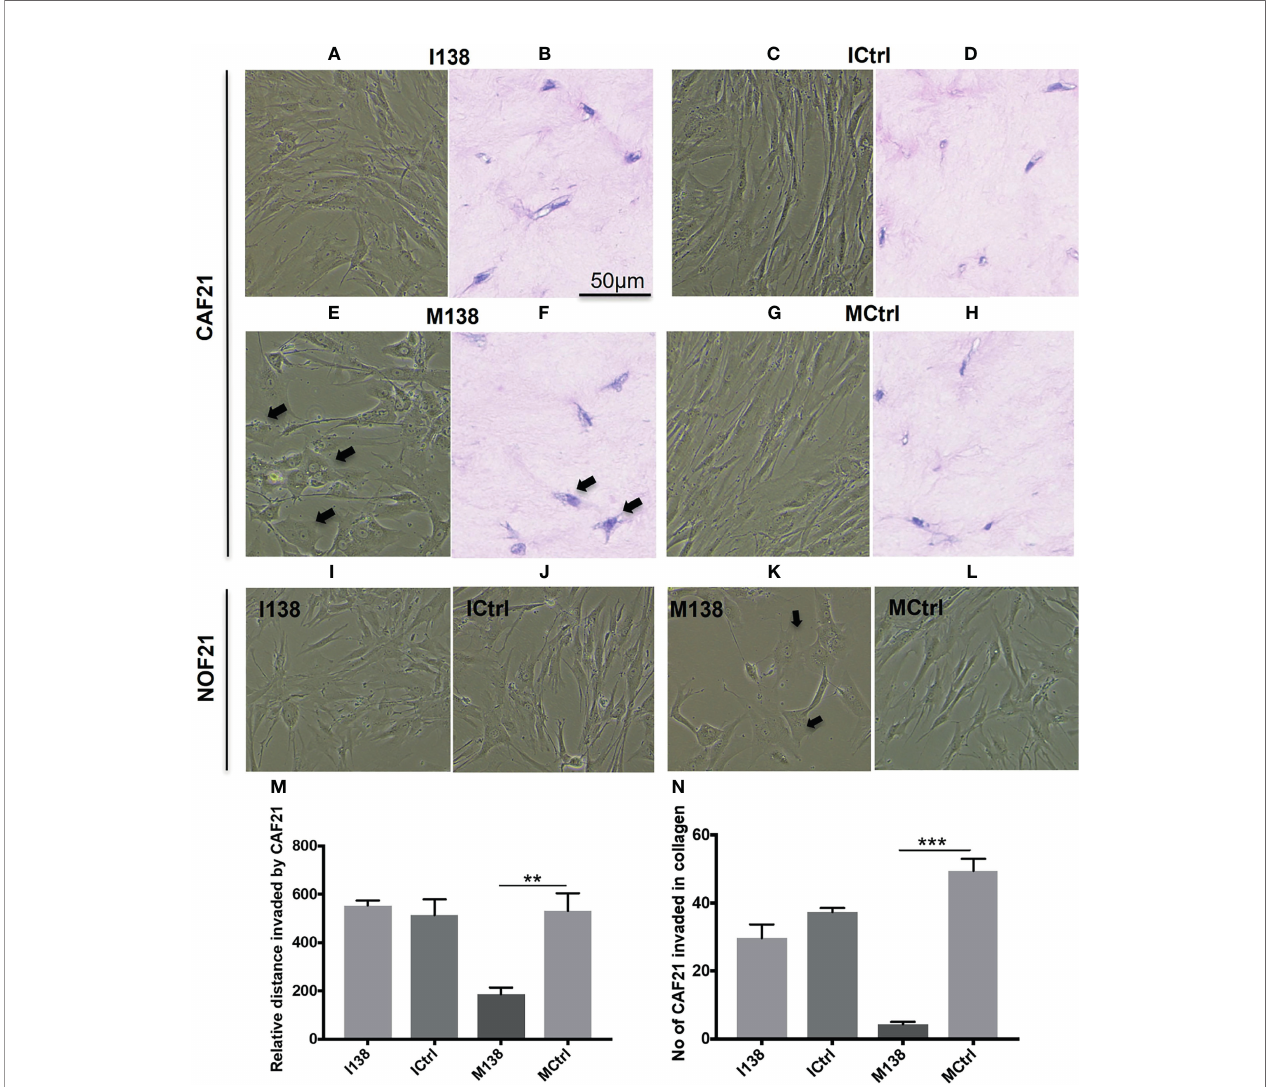
FIGURE 5 | Altered fi broblast morphology and migration following miR-138 modulation in CAF monolayer and 3D-collagen matrix. (A, C, E, G, I – L) Phase contrast images for cells in monolayer taken 48 h post transfection of mimic and inhibitor of miR-138, and respective mimic and inhibitor control (50 nM). (B, D, F, H) Images of HE-stained sections of fi broblasts in 3D-collagen matrix post miR-138 modulation (M, N) . Effect of miR-138 modulation in CAFs, in its migration (invasion) ability in collagen gel matrix. M138 — fi broblasts treated with miR-138 mimics. ( n = 4 – 6, unpaired t -test, ** p < 0.01, *** p < 0.001). I138 — fi broblasts treated with miR-138 inhibitors of miR-13. Ictrl and MCtrl — respective controls for inhibitors and